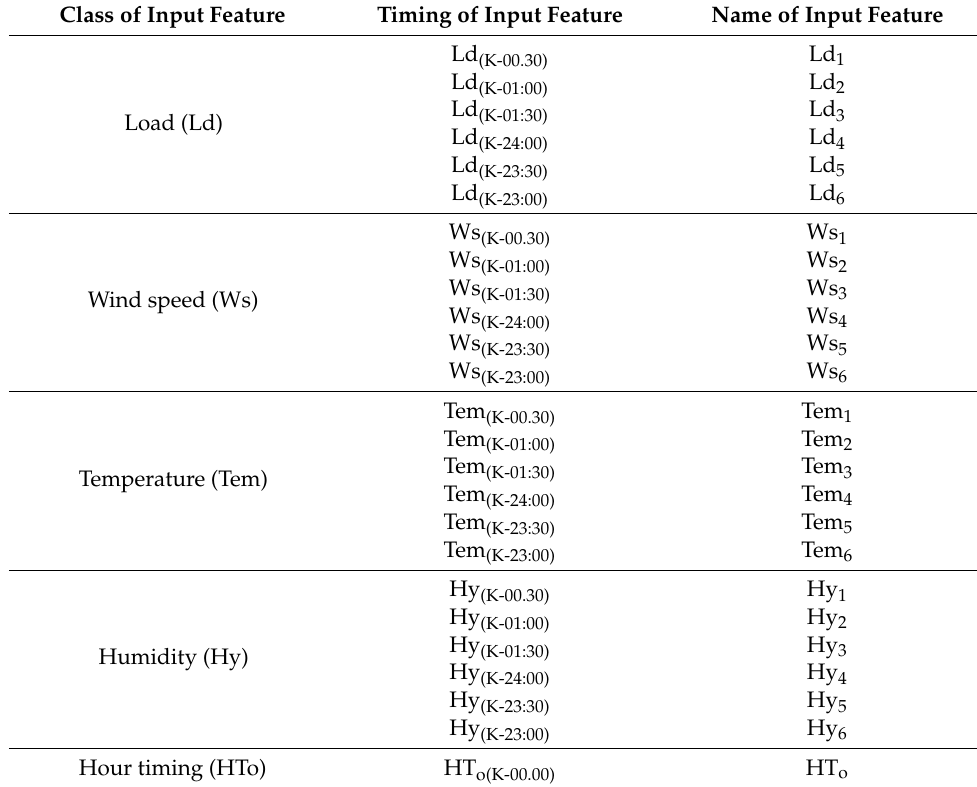
Table 2. Input features affecting half-hourly